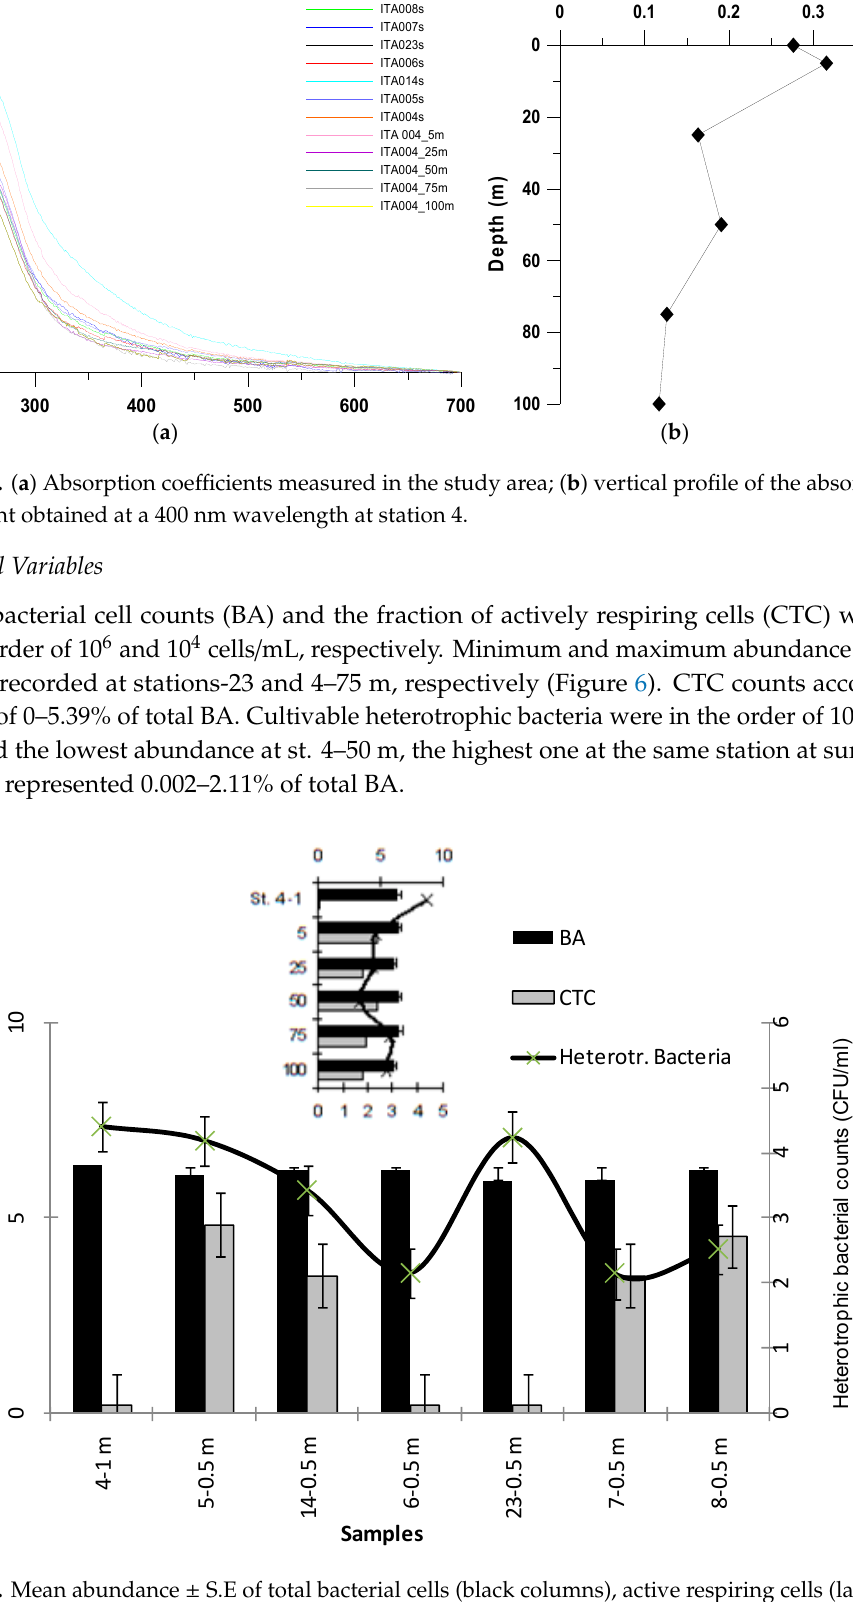
Figure 6. Mean abundance ± S.E of total bacterial cells (black columns), active respiring cells (labelled by CTC treatment, grey columns), heterotrophic bacteria (line).